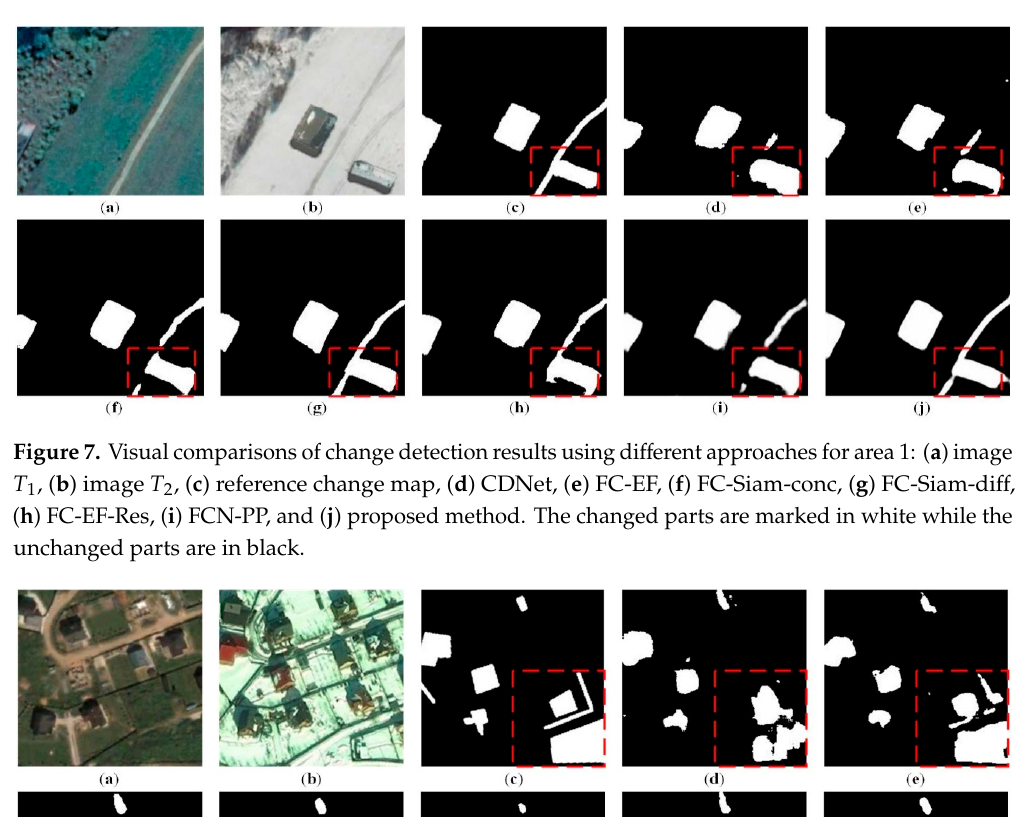
Figure 9. Visual comparisons of change detection results using different approaches for area 3: ( a ) image 𝑇 (cid:2869) , ( b ) image 𝑇 (cid:2870) , ( c ) reference change map, ( d ) CDNet, ( e ) FC-EF, ( f ) FC-Siam-conc, ( g ) FC- Siam-diff, ( h ) FC-EF-Res, ( i ) FCN-PP, and ( j ) proposed method. The changed parts are marked in white while the unchanged parts are in black.